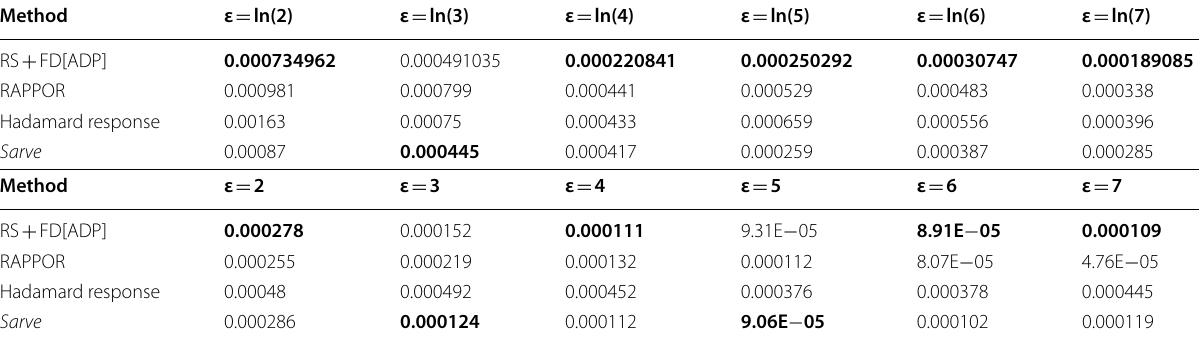
Table 4 The lowest MSE for the existing method and the enhancements which were tested on UCI nursery dataset